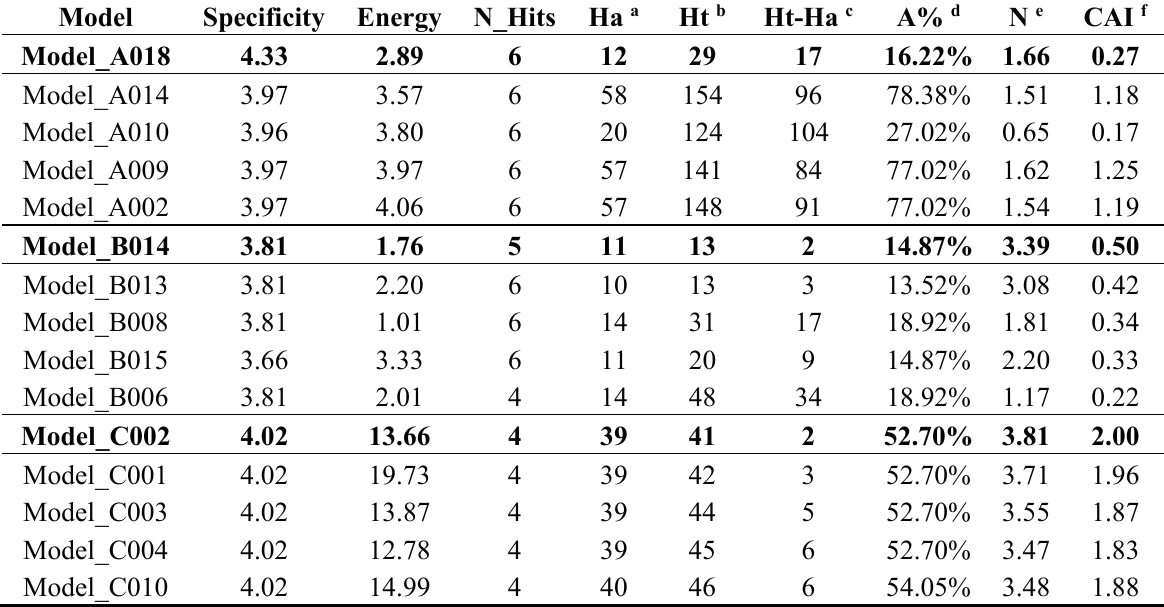
Table 1. The pharmacophore model validation results of each